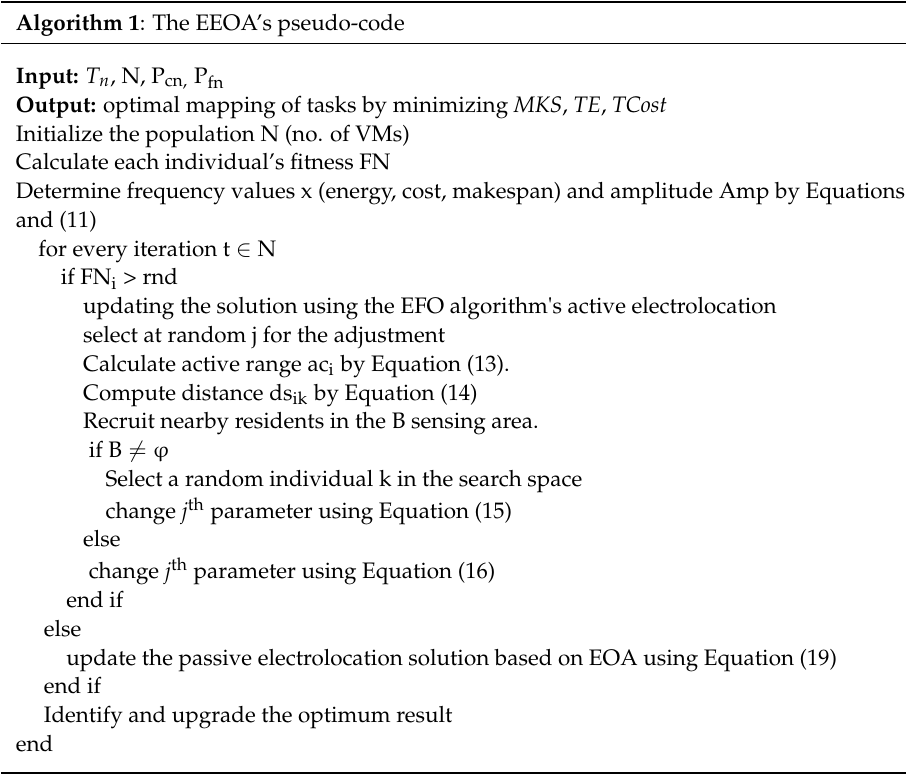
Algorithm 1 : The EEOA’s pseudo-code